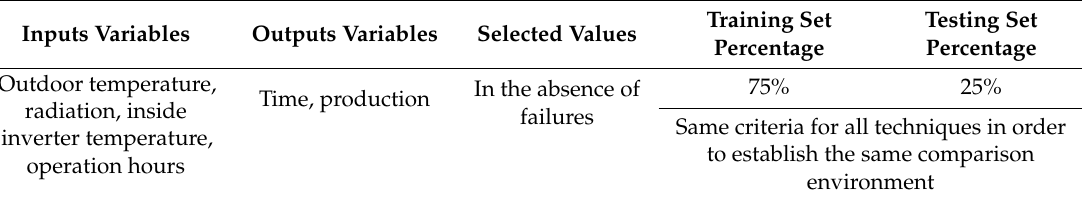
Table 4. Collected data in the study (treated and validated).